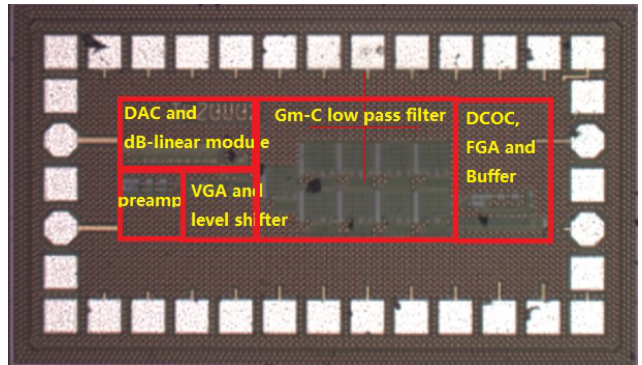
Figure 13. Chip microphotograph.